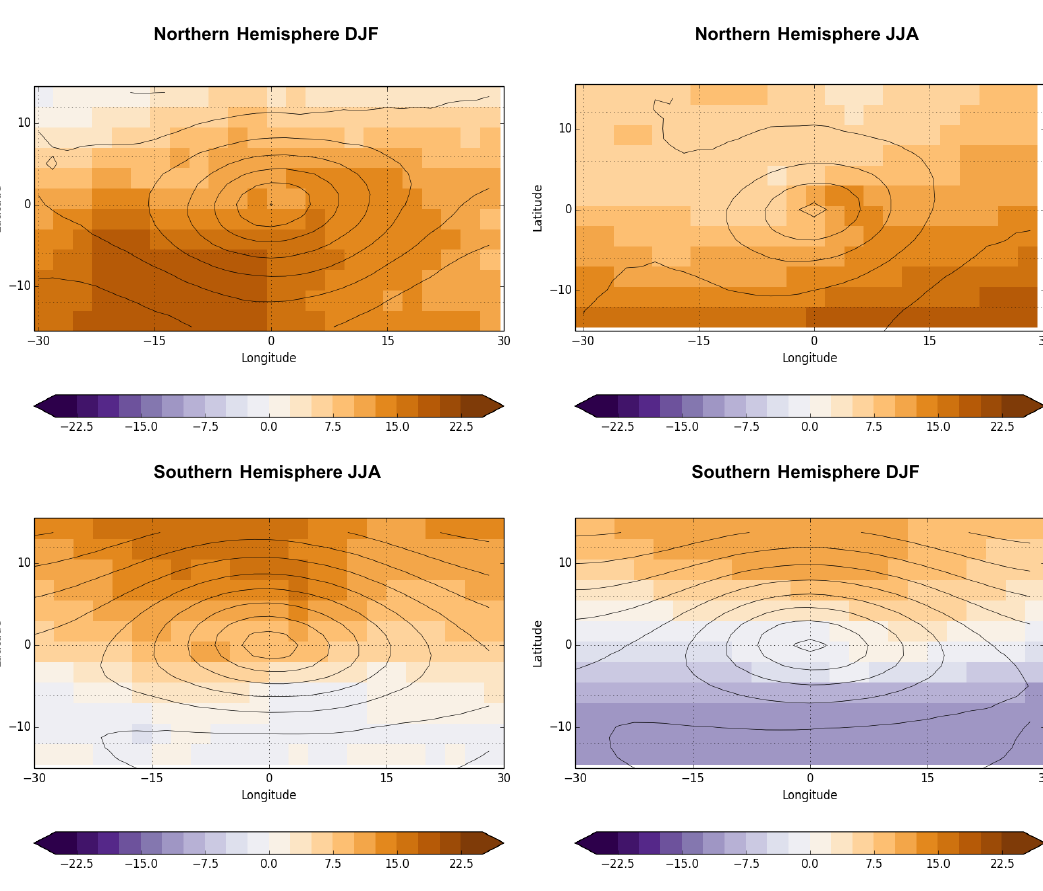
Figure 10. Cyclone composite GA7 mean bias in in-cloud albedo (%) against ISCCP (colours). Black contours are GA7